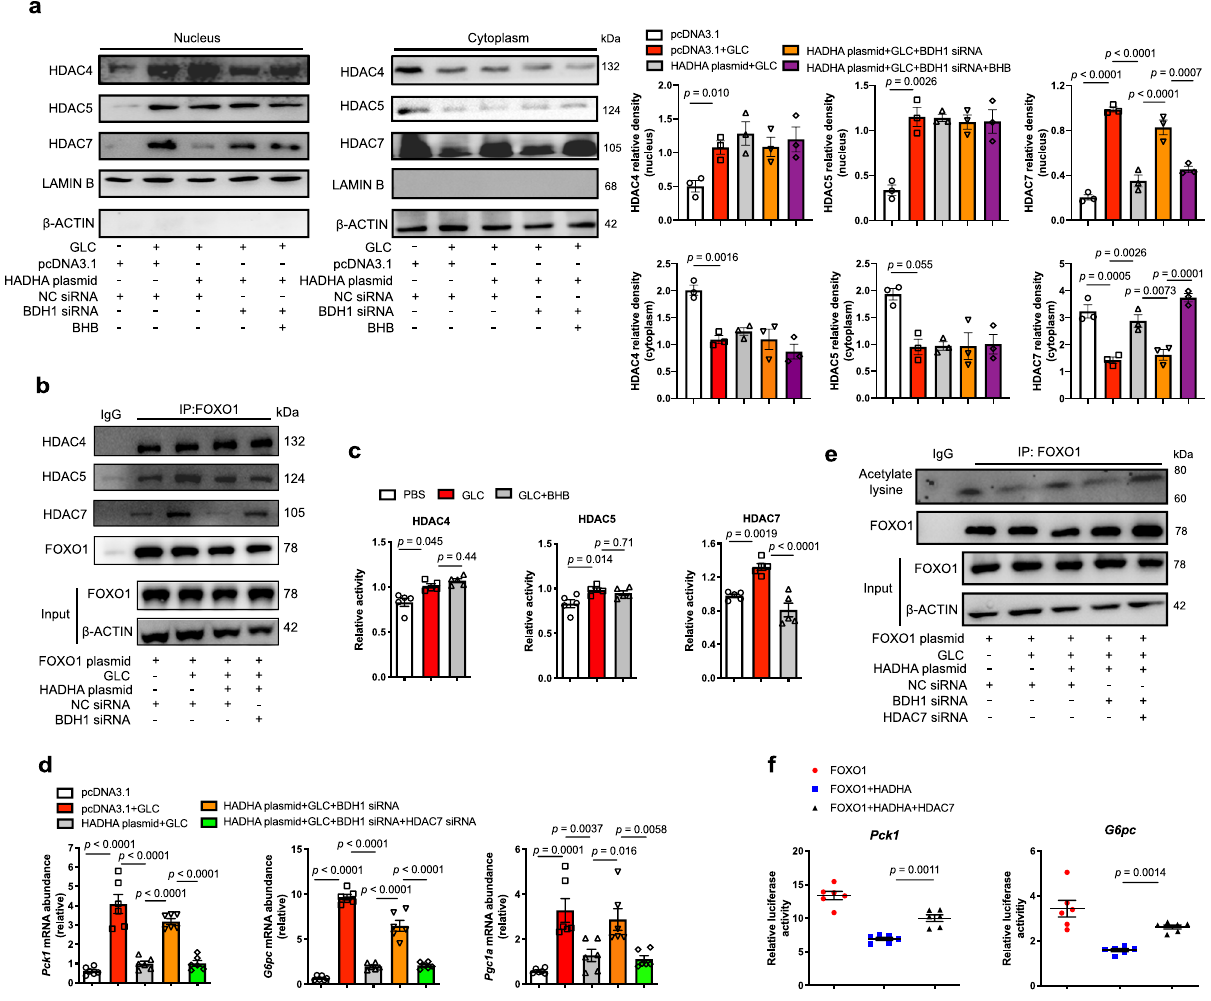
Fig. 5 BHB selectively inhibited HDAC7 to preserve FOXO1 acetylation. a The distribution of HDAC4, HDAC5 and HDAC7 in the nucleus and cytoplasm of HADHA-overexpressed hepatocytes transfected with BDH1 siRNA with or without BHB (400 μ M, 6 h) and 100 nM glucagon stimulation for 1 h ( n = 3). b Immunoprecipitation analysis of interaction of FOXO1 with HDAC4, HDAC5 or HDAC7 in HADHA-overexpressed hepatocytes with or without BDH1 siRNA transfection. It was repeated 3 times independently with similar results. c Enzyme activity of HDAC4, HDAC5 and HDAC7 in HepG2 cells with 100 nM glucagon stimulation for 1 h after BHB treatment (400 μ M, 6 h, n = 5). d Relative mRNA abundance of Pck1 , G6pc and Pgc1a in HADHA- overexpressed hepatocytes transfected with BDH1 siRNA and HDAC7 siRNA ( n = 6). e Immunoprecipitation analysis of FOXO1 acetylation in d . It was repeated 3 times independently with similar results. f Luciferase reporter assay of the effect of HADHA and HDAC7 on Pck1 and G6pc gene promoter. The Pck1 and G6pc luciferase reporters were co-transfected with HADHA, FOXO1 and HDAC7 plasmid in HEK-293T cells. The luciferase activity was normalized with the internal control (Renilla luciferase, n = 6). Values represent mean ± SEM. Statistical differences were determined by one-way ANOVA. Source data are provided as a Source Data fi